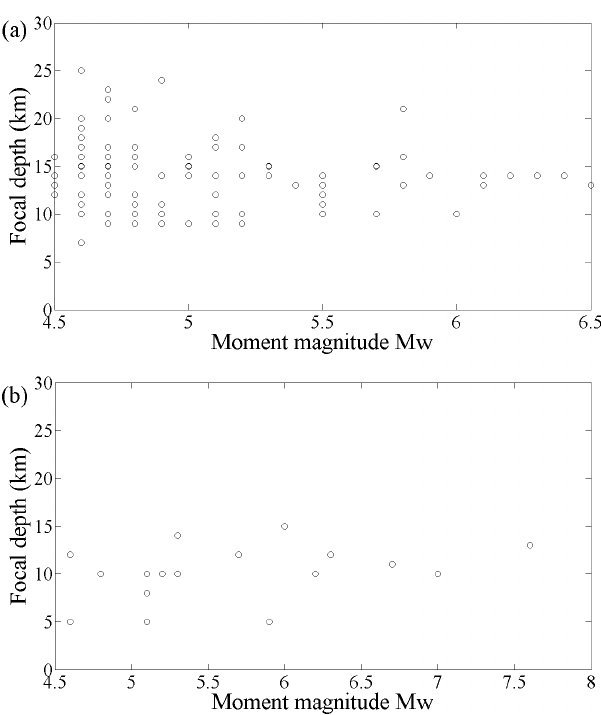
Figure 4. M w focal depth distribution of strong ground motion records in (a) the Sichuan region and (b) the Yunnan region.